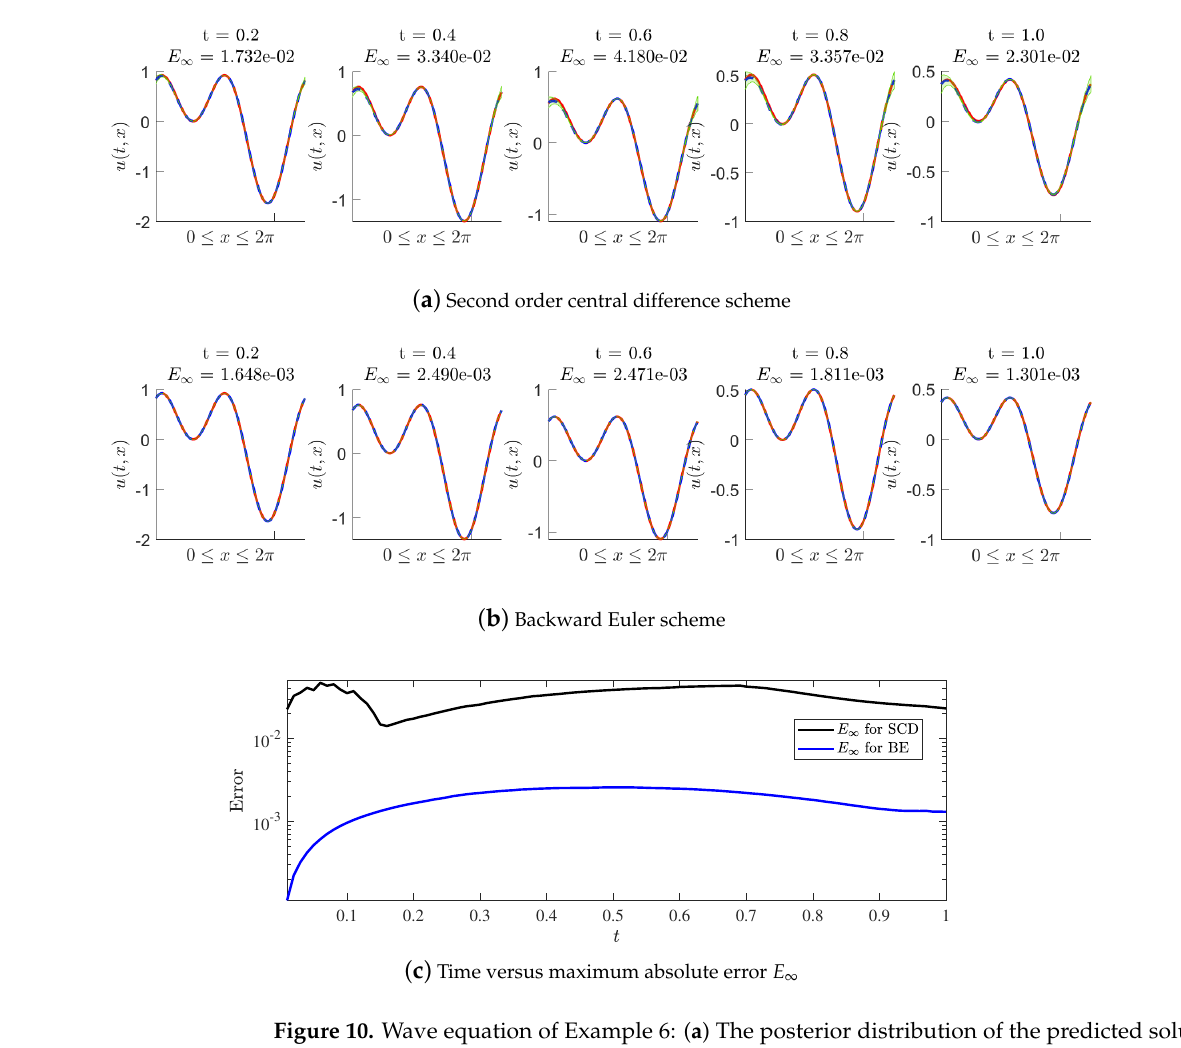
Figure 10. Wave equation of Example 6: ( a ) The posterior distribution of the predicted solution at different time nodes, where the second order central difference scheme is used. ( b ) The posterior dis- tribution of the predicted solution at different time nodes, where the backward Euler scheme is used. ( c ) Time versus maximum absolute error E ∞ until the final time step is reached, where the second order central difference scheme (SCD) and the backward Euler scheme (BE) are both